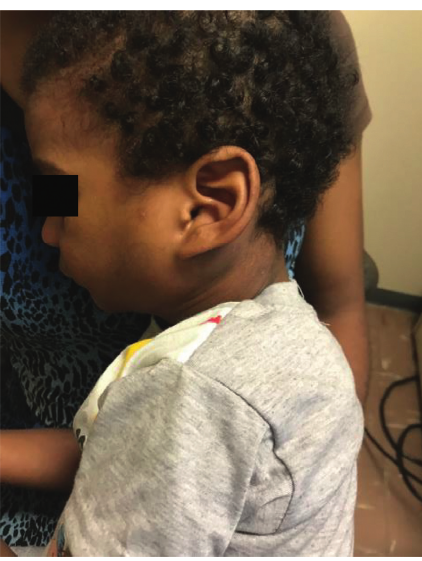
Figure 10: Cystic hygroma 12 months after